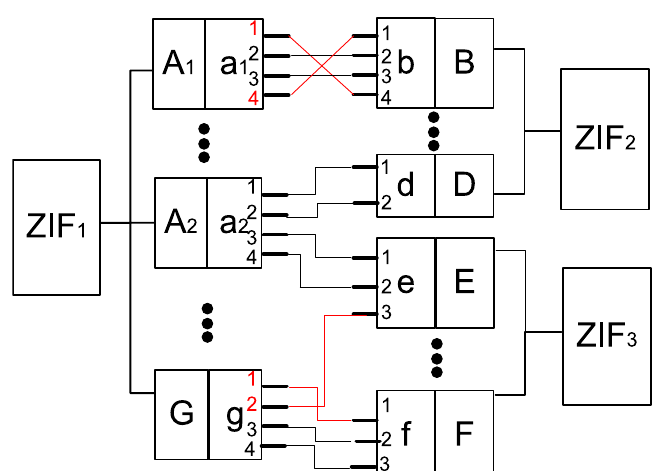
Fig. 10 Wrong connections among the aircraft plug connectors